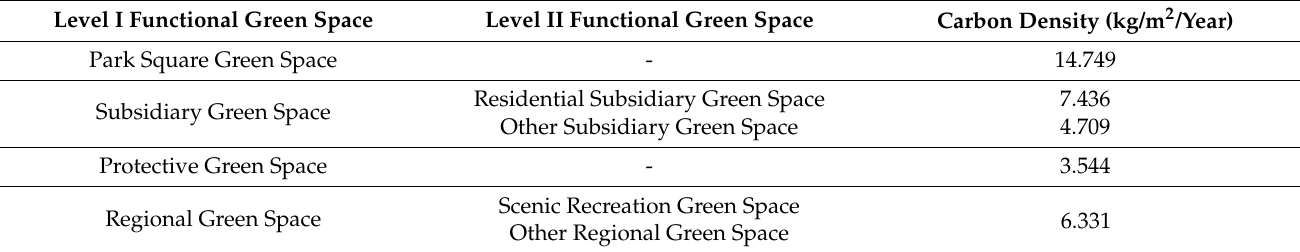
Table 4. Carbon fixation capacity of six functional UGS carbon